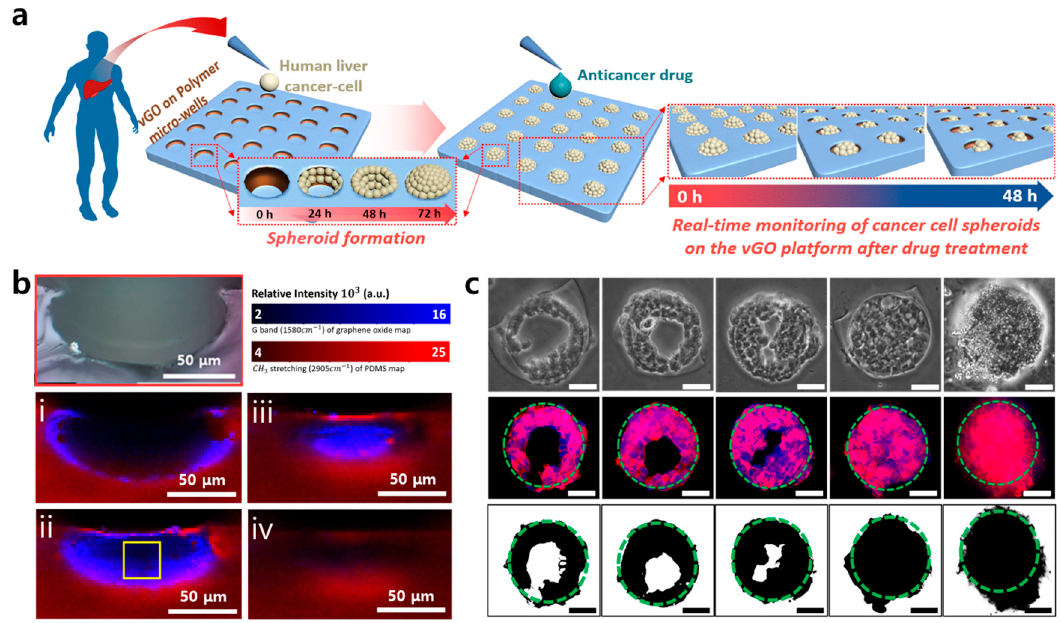
Figure 7. The characterization of the vertically coated graphene oxide micropattern (vGO-MP) platform. ( a ) Schematic illustration showing cancer cell spheroid formation on vGO-MP and anticancer drug screening process of cancer spheroids on the vGO-MP. ( b ) Raman mapping images of micro-well cross-section by focal point. ( c ) Optical microscopic images (top row), fluorescence images (middle row), and computer-based binary images (bottom row) of a HepG2 spheroid in a vGO-MP. Scale bars: 50 μ m. The reprint of this figure from [109] is permitted by John Wiley and Sons.